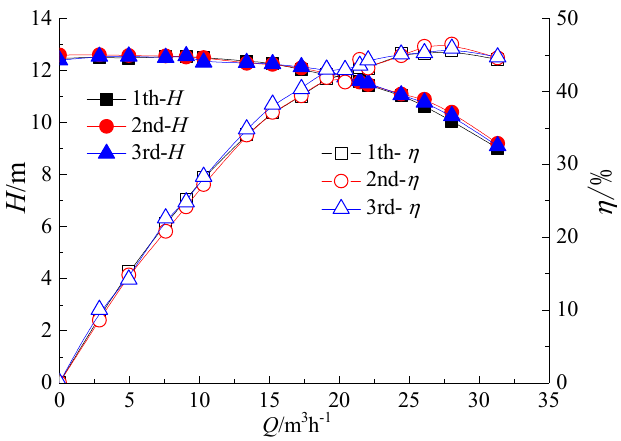
Figure 21. Performance curves of repetitive testing.